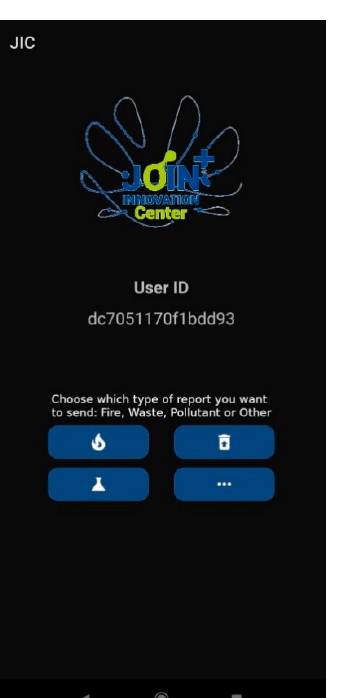
Figure 1. The main parts of the proposed system: the mobile application, the smart city platform which includes the application server (back end) and the web front end, and the system to plan and manage the inspections made by a drone. * Image from flaticon.com, accessed on 7 July 2022.